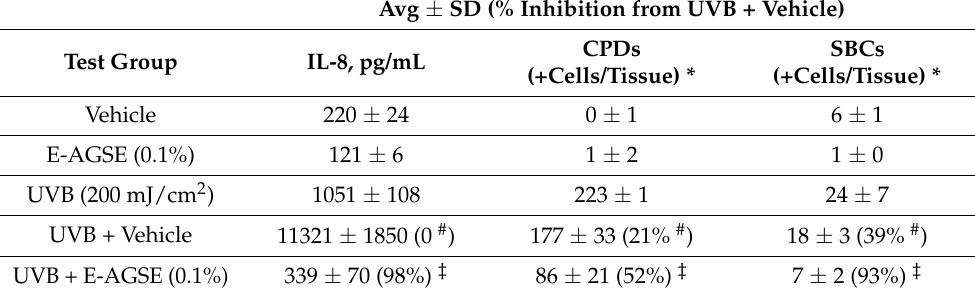
Table 4. Results for UVB-induced skin damage in